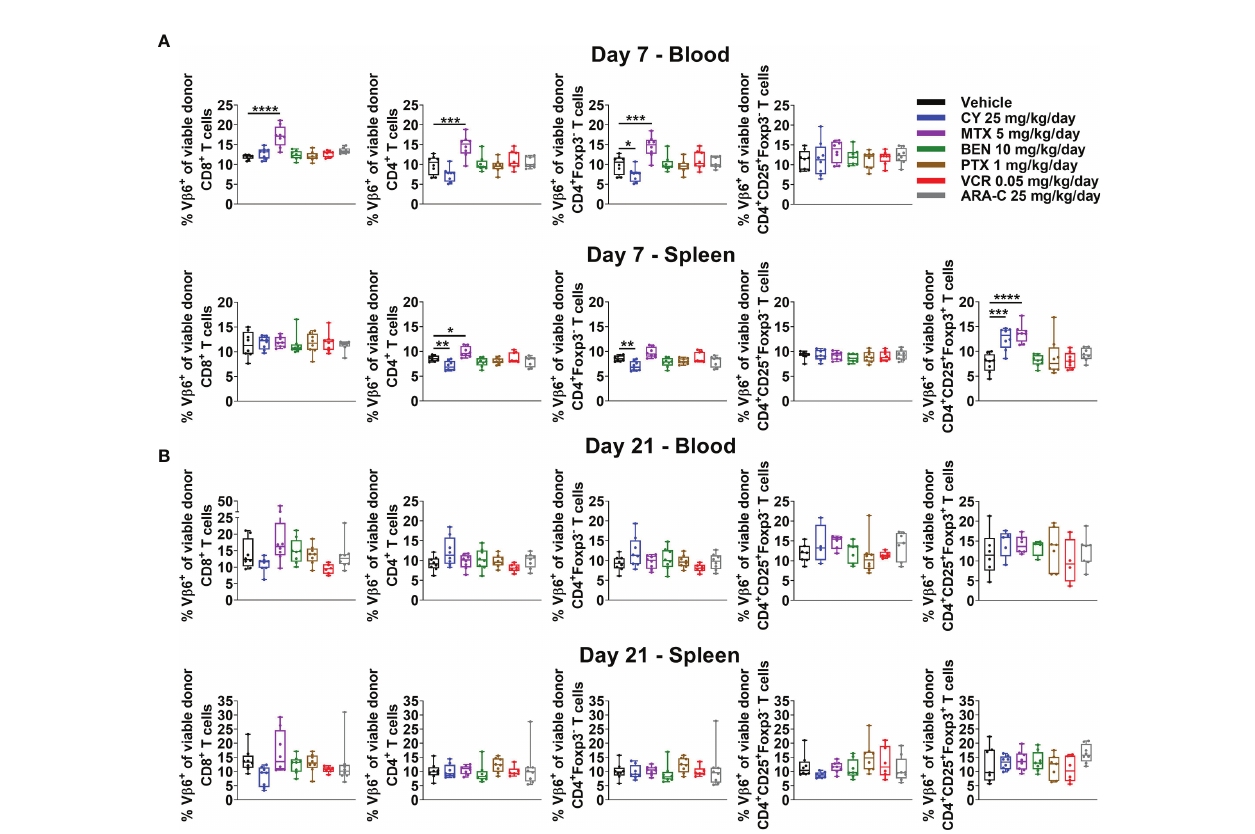
V b 6 + T cells were not eliminated by any chemotherapeutic at either (A) day +7 or (B) day +21. (A) In fact, at day +7, percentages of CD8 + , CD4 + , and CD4 + Foxp3 - T cells that were V b 6 + were increased in MTX-treated mice. The percentages of CD4 + Foxp3 - T cells that were V b 6 + were slightly reduced after CY although other T-cell subsets, including percentages of CD4 + CD25 + Foxp3 - that were V b 6 + , were not affected. Interestingly, alloantigen-speci fi c CD4 + CD25 + Foxp3 + cells were increased in CY- and MTX-treated mice at day +7 in the spleen; percentages in the blood were not included due to low total numbers of CD4 + CD25 + Foxp3 + cells at day +7 across treatment groups that did not permit reliable determination of further subsetting. (B) At day +21, there were no signi fi cant differences in percentages of V b 6 + T cells across T-cell subsets or treatment groups. Combined results from two independent experiments are shown with n = 4/group/experiment except VCR (n = 6 total) in B due to excess early deaths. *p < 0.05, **p < 0.01, ***p < 0.001, ****p < 0.0001 on one-way ANOVA followed by the Holm-Sidak post hoc test using the vehicle-treated group as the control. Only signi fi cant results are shown; all other comparisons between treatment groups and the vehicle group are non-signi fi